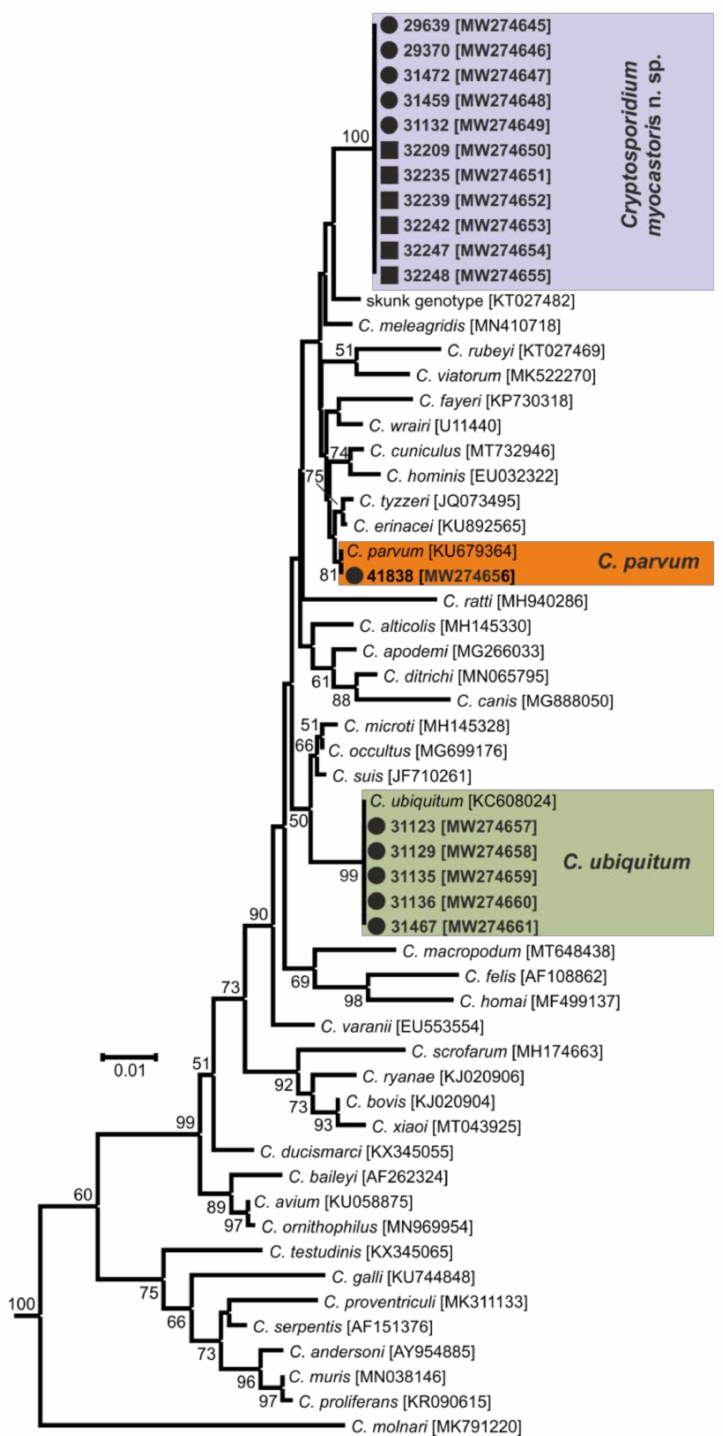
Figure 2. Maximum likelihood tree based on partial small subunit ribosomal RNA gene sequences of Cryptosporidium spp., including sequences obtained in this study (bolded and highlighted). The alignment contained 770 base positions in the final dataset. Numbers at the nodes represent the boot strap values with more than 50% boot strap support from 1000 pseudo replicates. The branch length scale bar, indicating the number of substitutions per site, is given in the tree. Sequences from this study are identified by an isolate number (e.g., 32247). Black circles and squares indicate natural and experimental infections,